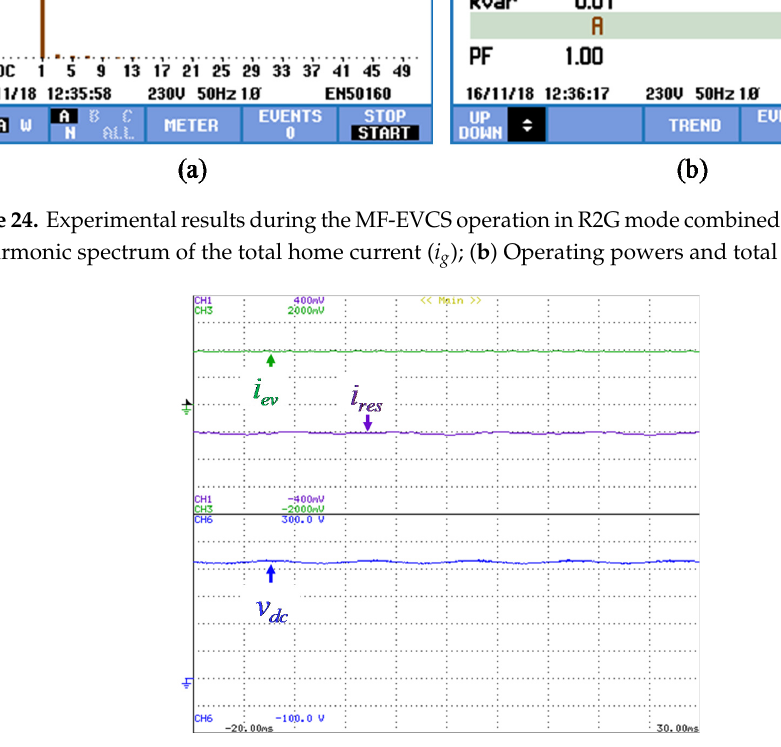
Figure 25. Experimental results during the MF-EVCS operation in R2G mode combined with G2V mode: Current in the EV battery ( i ev : 2 A/div); Current in the RES interface ( i res : 1 A/div); Dc-link voltage ( v dc : 50 V/div).